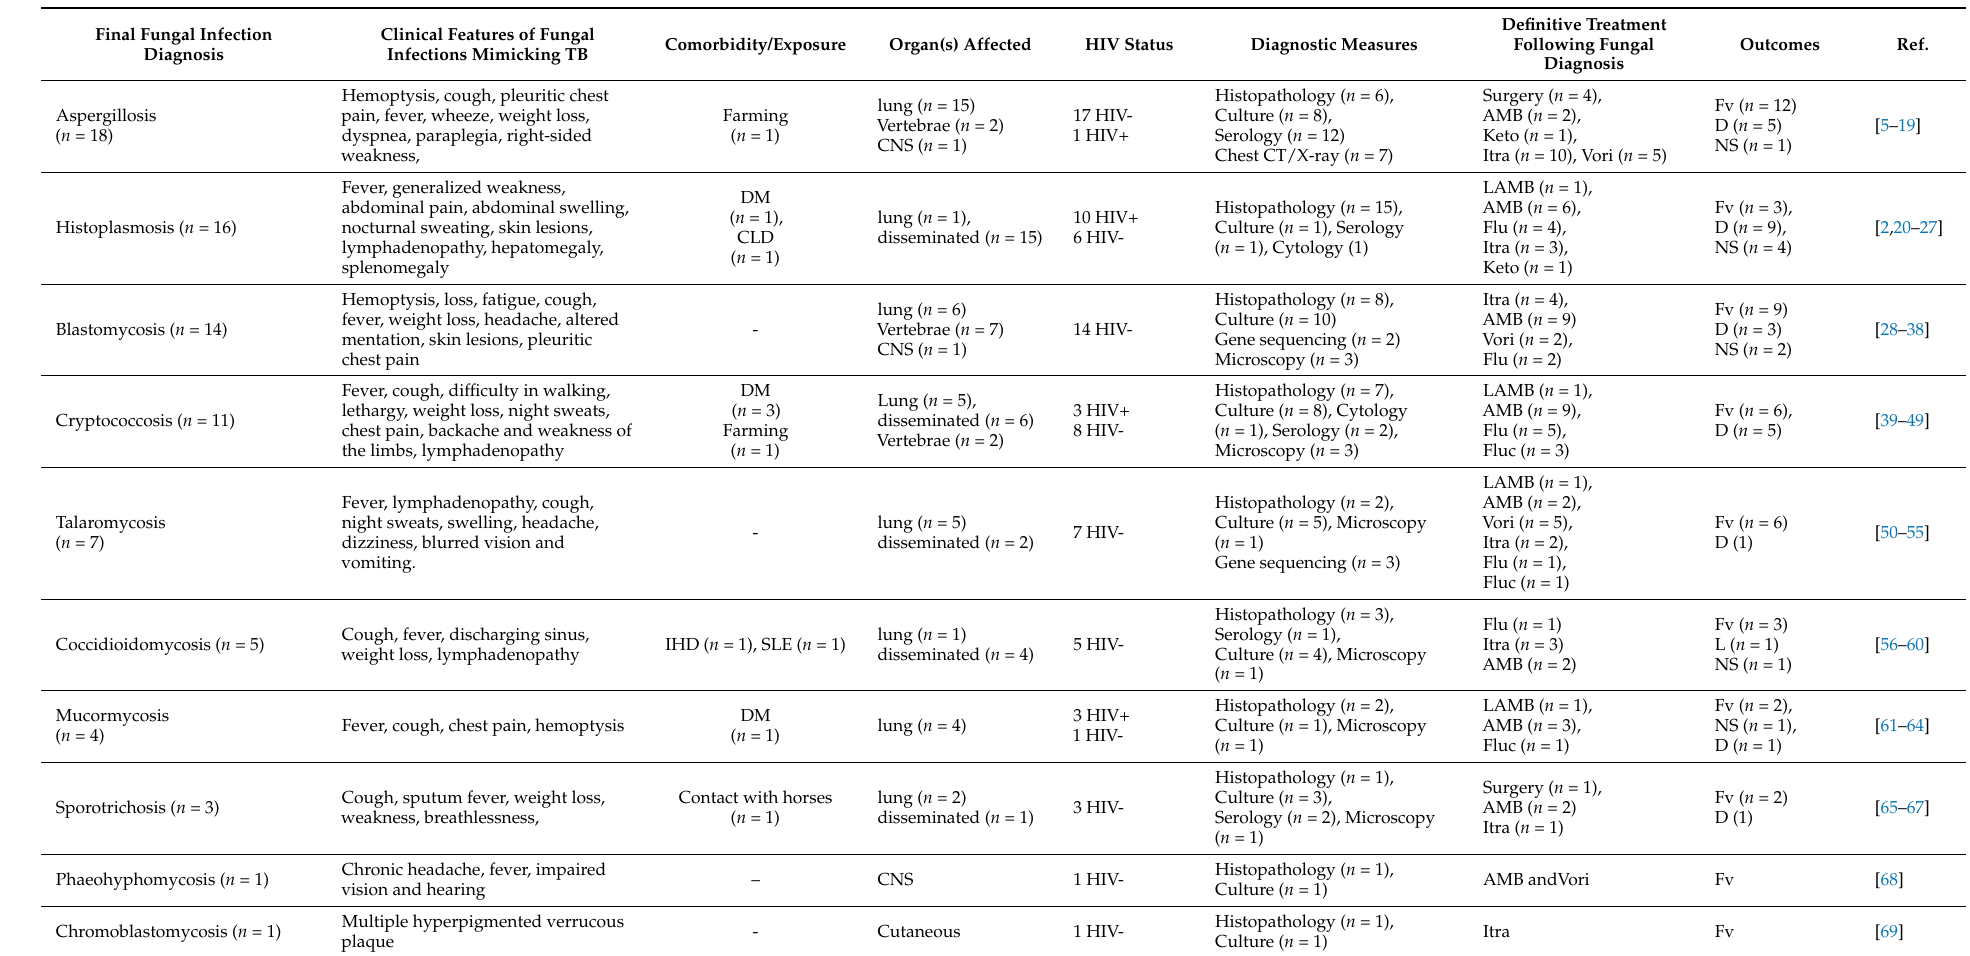
Table 1. Clinical summary of fungal infections misdiagnosed as